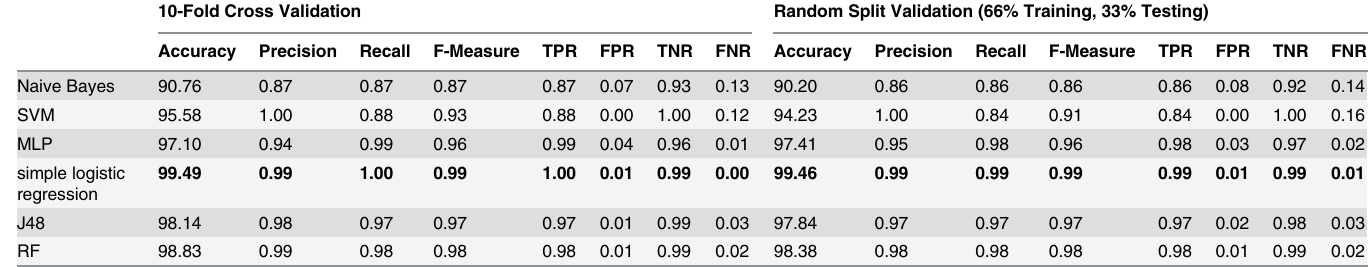
Table 6. Model Comparison between 10-fold and random sampling. 10-Fold Cross Validation